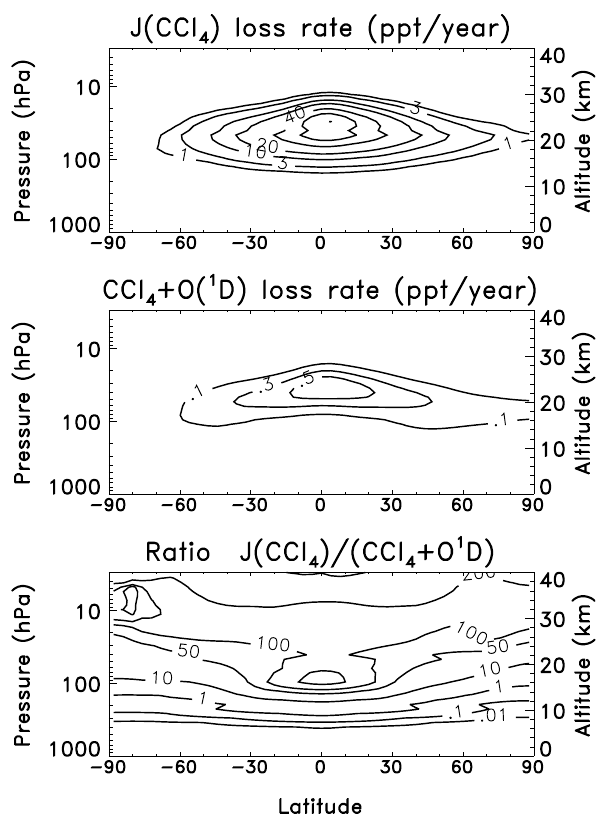
Fig. 6. (Top) Modeled photochemical loss rate of CCl 4 due to pho- tolysis (in parts per trillion per year) using the UV absorption cross sections obtained in this work. Also shown are the CCl 4 loss rate due to reaction with O( 1 D) (middle), and the ratio of the photolysis loss to the O( 1 D) loss (bottom). All values are annual averages for year 2000. The contours plotted in the top panel are 1, 3, 10, 30, 50, and 70 ppt/year.